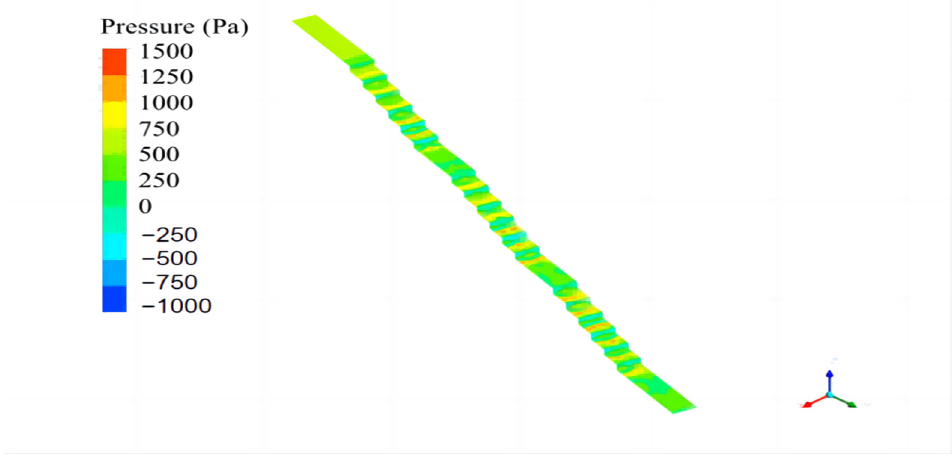
Figure 11. Pressure distribution of conventional step dissipator at Q = 30 m 3 /h.